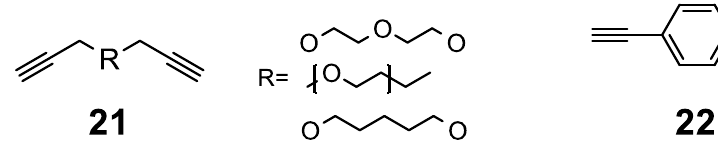
Figure 13. CuAAC crosslinking and functional monomers used.